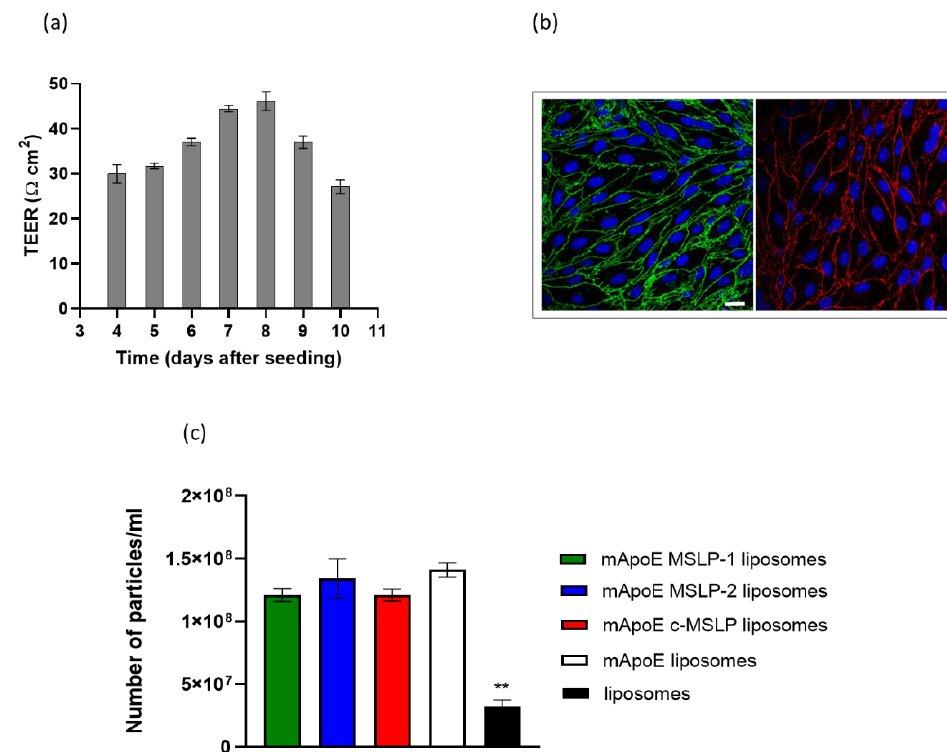
Figure 6. Characterization of a BBB in vitro model and evaluation of its permeability to MSLP-liposomes. ( a ) TEER values of the cell monolayer from day 4 to day 10 of its growth on a transwell. ( b ) Confocal microscopy visualization of junctions (blue, nuclei; green, claudin-5 and red, VE-cadherin). Bars represent 20 μm. ( c ) Evaluation of the permeability of mApoE-MSLP-liposomes across an endothelial monolayer after 3 h incubation by NanoSight. Results are expressed as mean ± SD ( n = 3). ** p < 0.01 (Student’s t test).